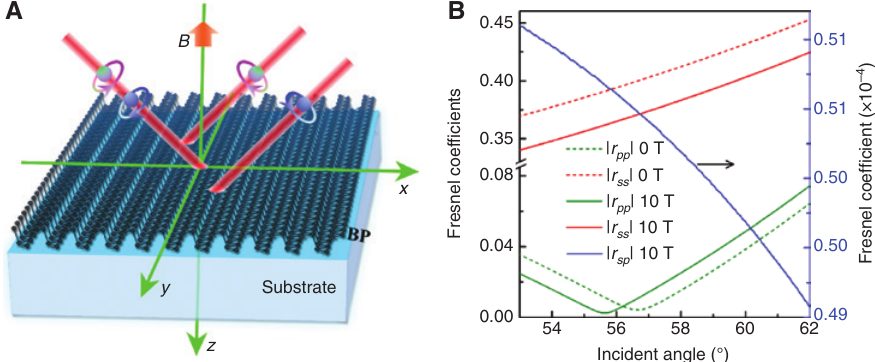
Figure 1: The energy of incident photon is 1.8 eV. (A) Schematic representation of the photonic spin splitting of one Gaussian beam reflected from a BP–substrate interface. An imposed static magnetic field B is applied along the negative z axis in a Cartesian coordinate system. (B) The Fresnel reflection coefficients with B = 0 and 10